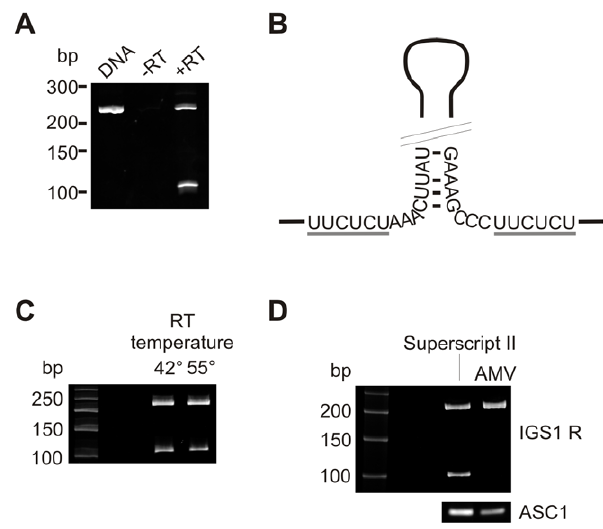
Figure 1. An apparent non-canonical intron in the IGS1 R non- coding RNA. A: 35 cycle RT-PCR across the apparent intron on cDNA synthesized with Superscript II and genomic DNA. cDNA was produced from a trf4 D strain where this non-coding RNA is stabilized. B: Hairpin structure of IGS1 R, short homologous repeats are underlined in grey. C: 35 cycle RT-PCR across the apparent intron on trf4 D cDNA synthesized using Superscript II at 42 u C or Superscript III at 55 u C. D: 35 cycle RT-PCR across the apparent intron on trf4 D cDNA synthesized using Superscipt II or AMV. Control shows 30 cycle RT- PCR reaction across the ASC1 mRNA intron on the same cDNA